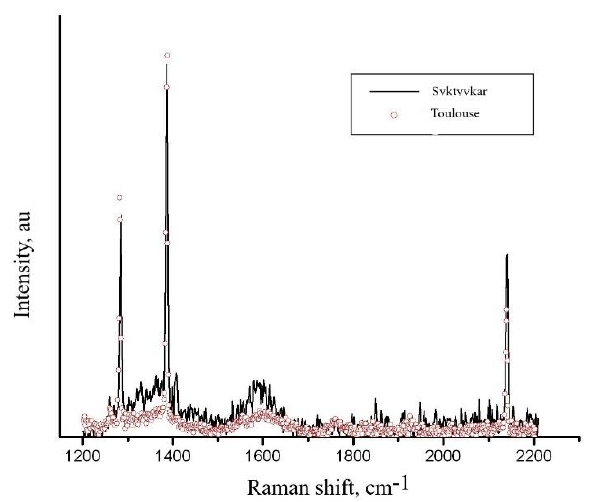
Figure 4. Raman spectrum of the same fluid bubble from AGT of the run ab108 recorded in two laboratories. CO band is near k = 2140 cm −1 and CO 2 bands are at k = 1388 cm −1 and 1286 cm −1 .